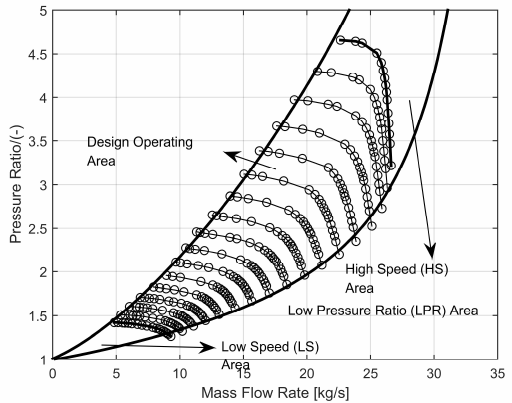
Figure 3. Zone division standard of the compressor performance map.